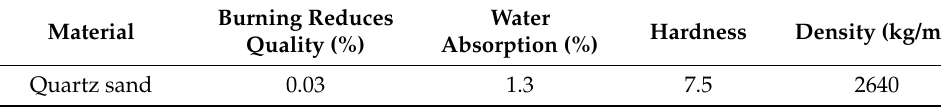
Table 2. Performance indices of quartz sand. Table 1. Performance indices of sulphoaluminate cement.